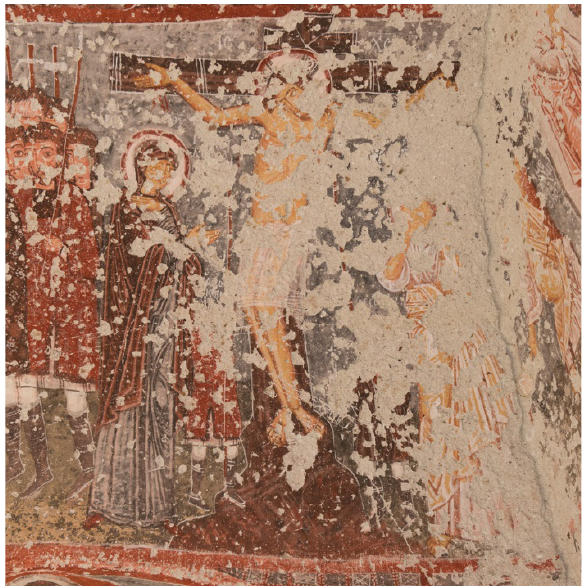
Figure 7. The Crucifixion of Sarnıç Kilisesi (current image)